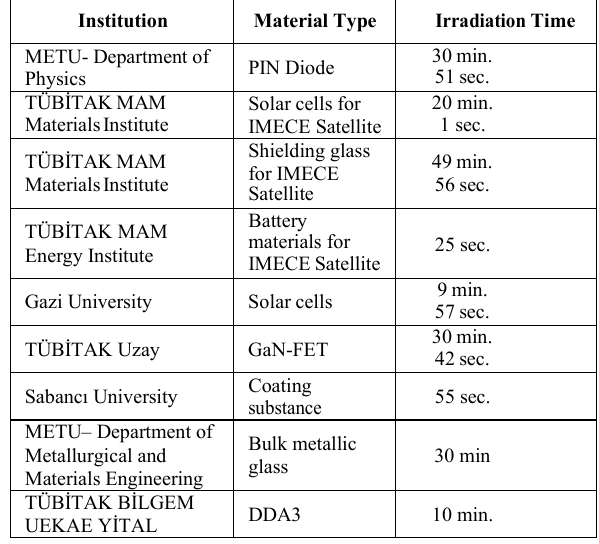
TABLE II. Radiation tests which performed during the pretest of METU- DBL .